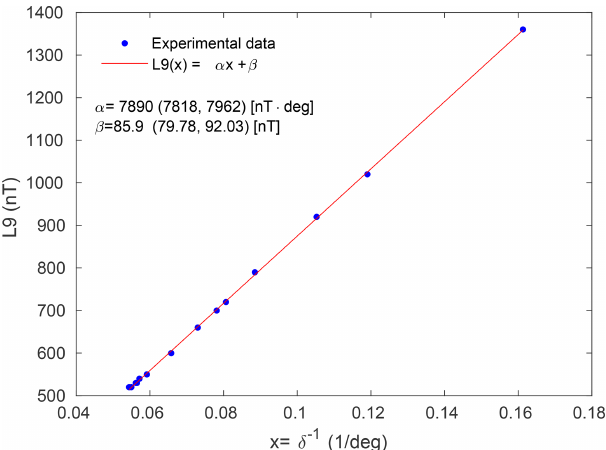
Figure 8. The linear relation between the L9 limit and x = 1 /δ (Eq. 1) with values from Mayaud (1980). The linear regression fit results are shown: α and β coefficients and their 95% confidence intervals.